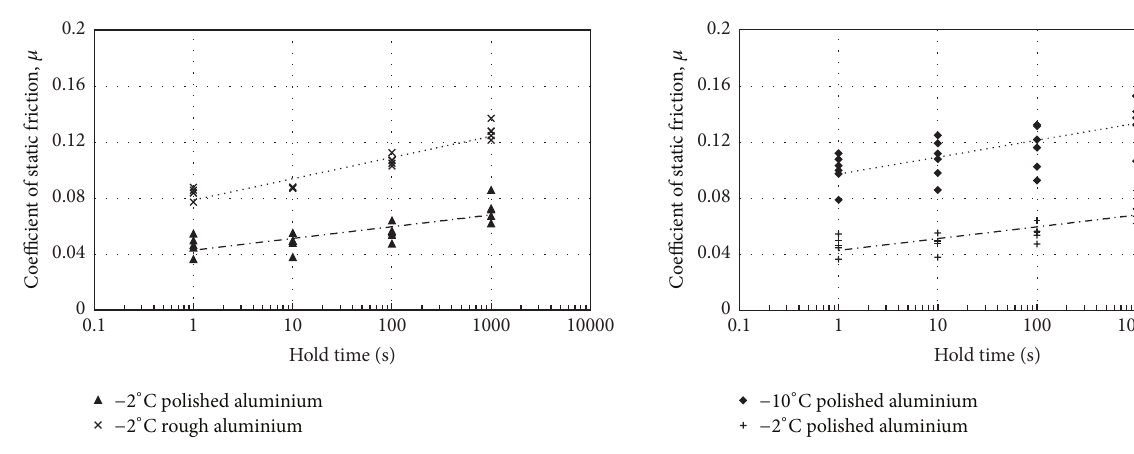
Figure 6: Friction as a function of hold time for experiments involving polished aluminium, comparing − 2 ∘ C (+) and − 10 ∘ C (dia- monds). A logarithmic line of best fit is fitted to the average results. The data compared here are also shown separately in Figures 4 and 5.